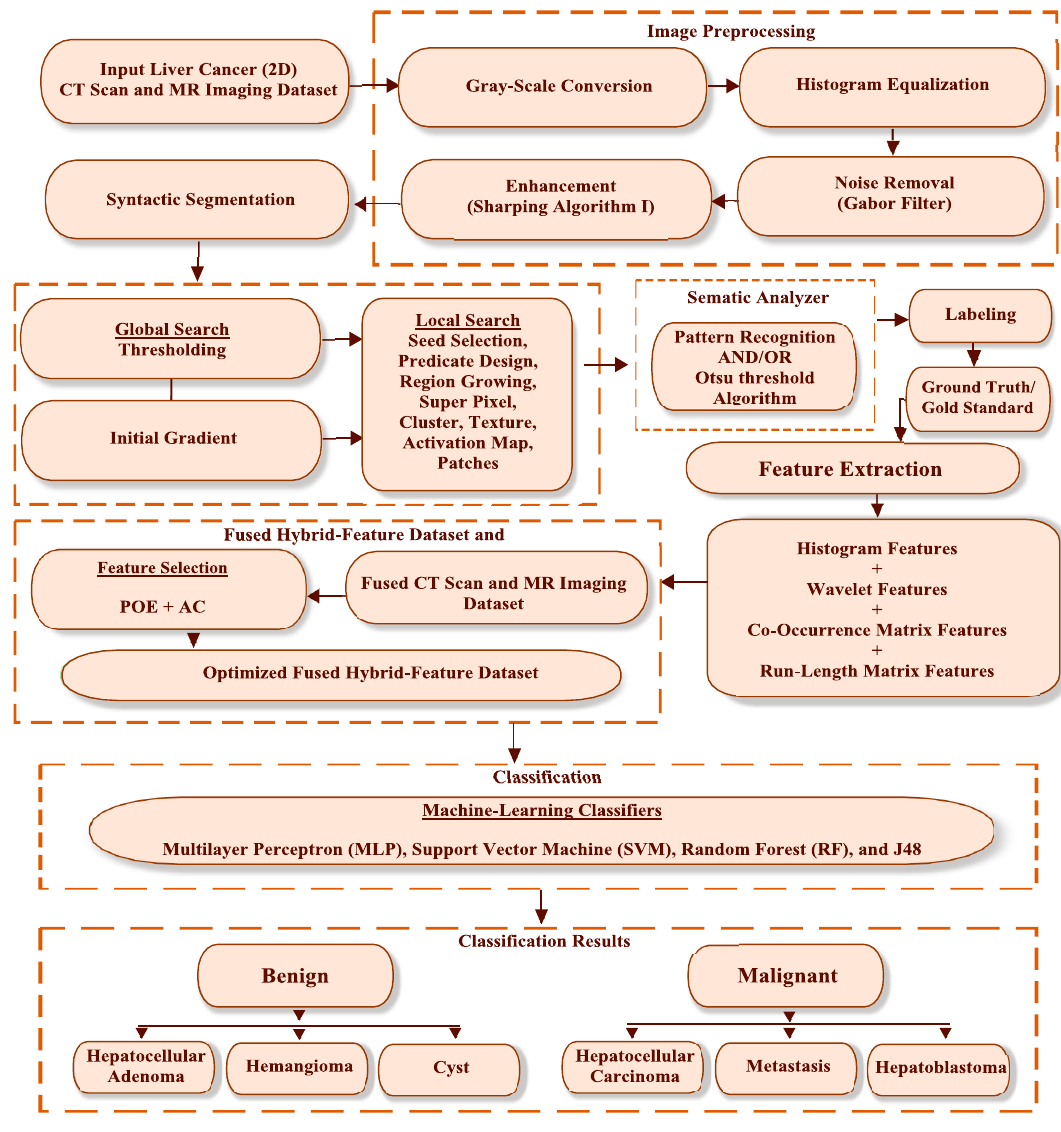
Figure 2. Otsu thresholding-based segmentation and fused hybrid-feature analysis for liver cancer classification framework.